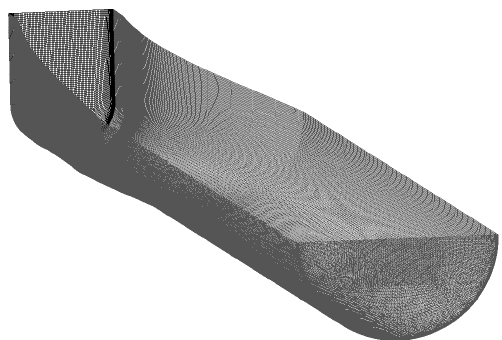
Figure 7. Computational grid of turbine inlet.